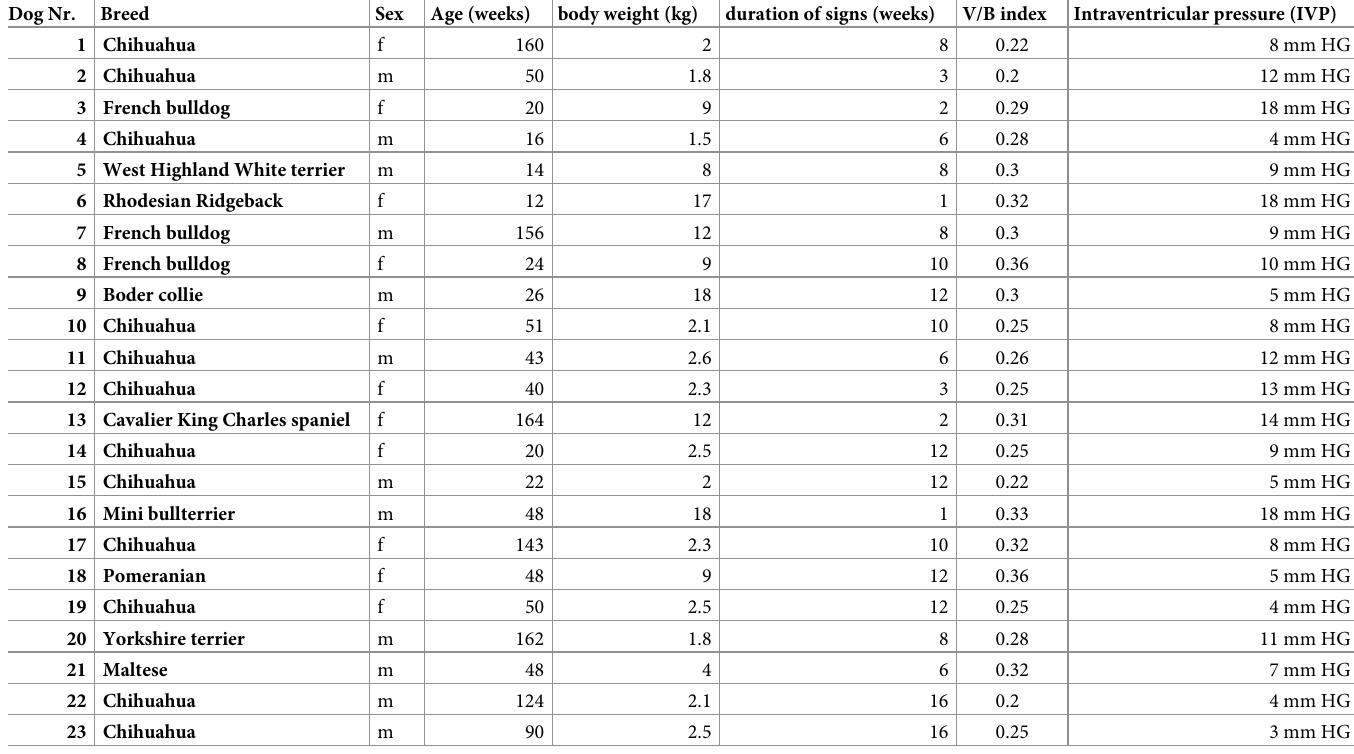
Table 1. Epidemiological data and results of volume- and intraventricular pressure measurements of dogs with internal hydrocephalus. Dog Nr. Breed Sex Age (weeks) body weight